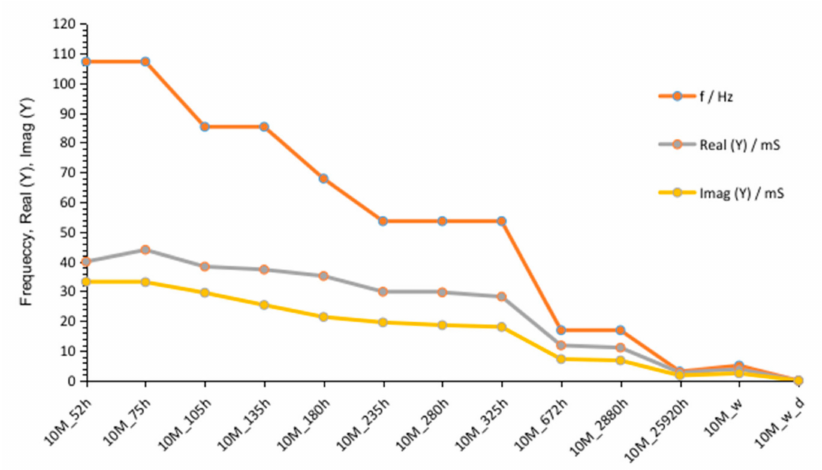
Figure 11. Changes of frequencies, admittance, and susceptance depending on time passed from starting polymerization after removing conductive ions (G10M_w) and drying concrete (G10M_w_d).